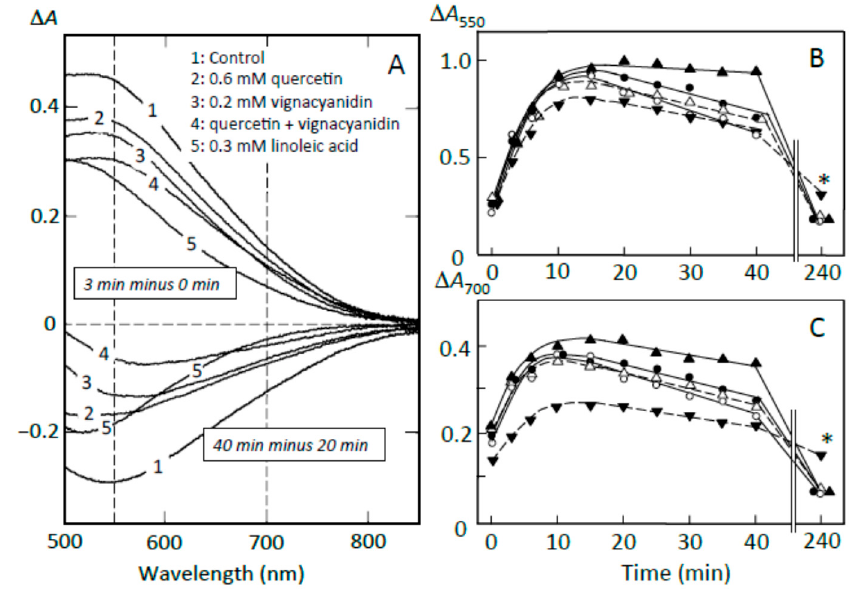
Figure 8. Effects of adzuki components on starch digestion of retrograding joshinko. ( A ) ∆ A spectra. Upper traces , 3 min minus 0 min of incubation; lower traces , 40 min minus 20 min incubation. ( 1 ) no addition, ( 2 ) 0.6 mM quercetin, ( 3 ) 0.2 mM vignacyanidin, ( 4 ) 0.6 mM quercetin + 0.2 mM